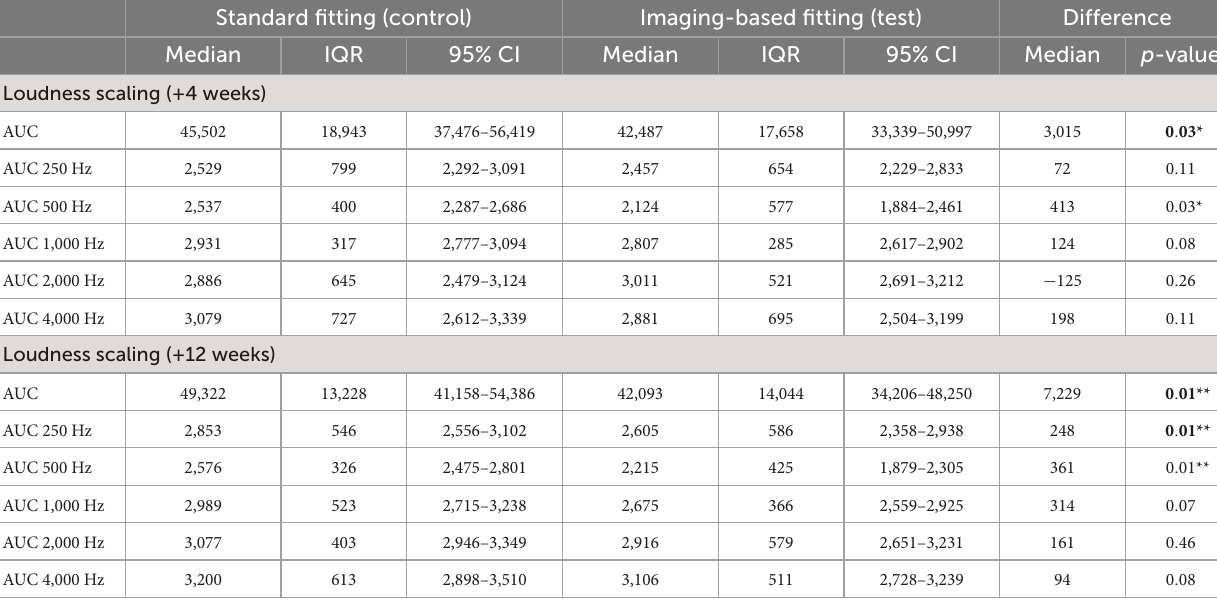
TABLE 5 Loudness growth with the imaging-based and standard fitting, expressed as AUC across frequencies and for each measured frequency separately. Standard fitting (control) Imaging-based fitting (test)